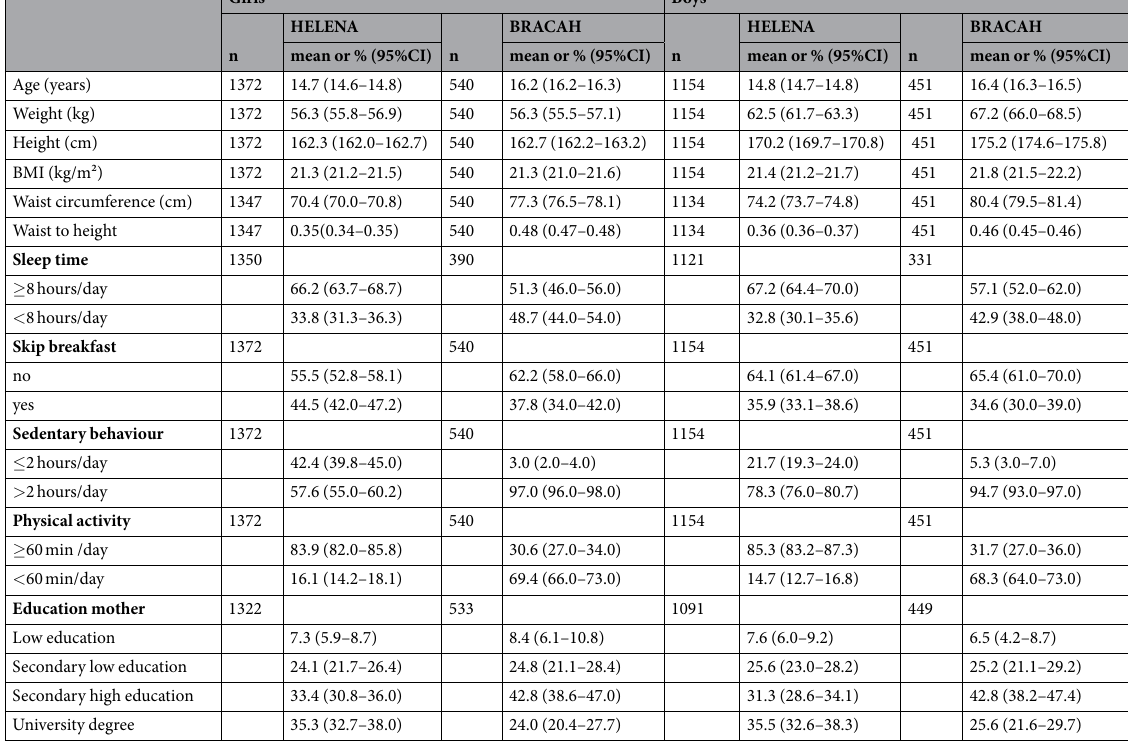
Table 1. Main characteristic of the studied adolescents from HELENA-CSS and BRACAH studies. HELENA- CSS: Healthy Lifestyle in Europe by Nutrition in Adolescence cross-sectional study, BRACAH study: Brazilian Cardiovascular Adolescent Health study, 95%CI: confidence